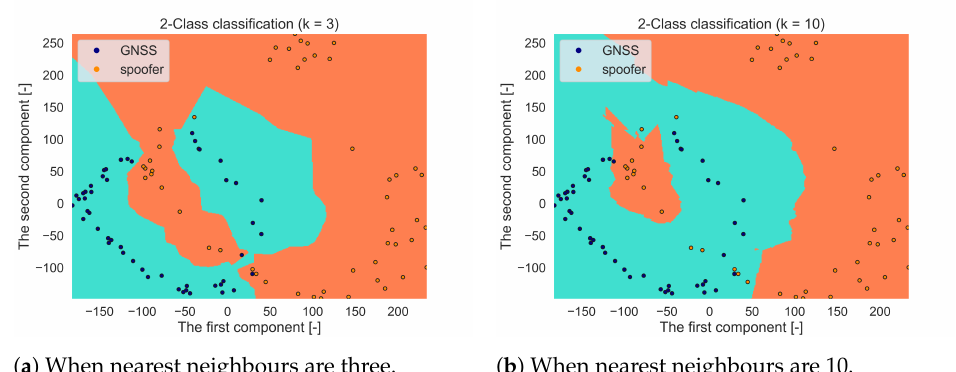
Figure 13. An example of KNN for three nearest neighbours.